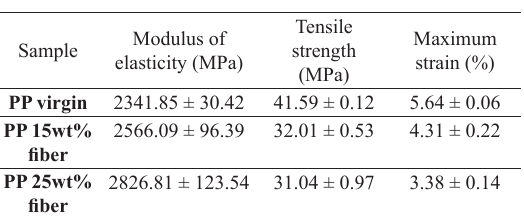
Table 9. Tensile test results.